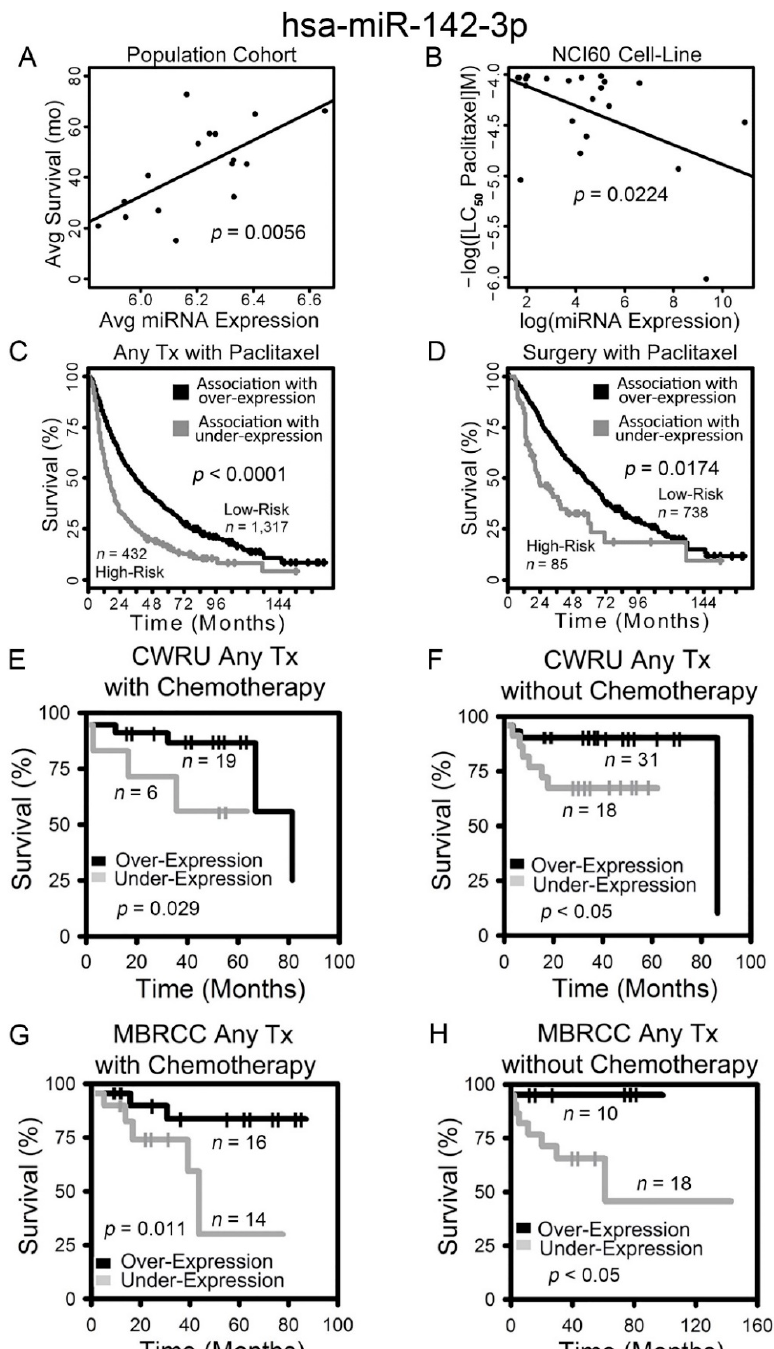
Figure 2. Overexpression of hsa-miR-142-3p correlates with prolonged survival and chemosensitivity in non-small cell lung cancer (NSCLC) patients. Correlation between hsa-miR-142-3p expression and survival in SEER-Medicare lung squamous cell carcinoma (LUSC) patient population ( A ), and the dosage required for lethal concentration (LC 50 ) of paclitaxel in the NCI-60 ( B ). Kaplan– Meier analyses of patient stratification based on hsa-miR-142-3p expression in all SEER-Medicare LUSC patients treated with paclitaxel ( C ) and patients receiving only surgery and paclitaxel ( D ), CWRU patients receiving chemotherapy ( E ) or without chemotherapy ( F ), and MBRCC patients receiving chemotherapy ( G ) or without chemotherapy ( H ). Log-rank tests were used to assess the statistical